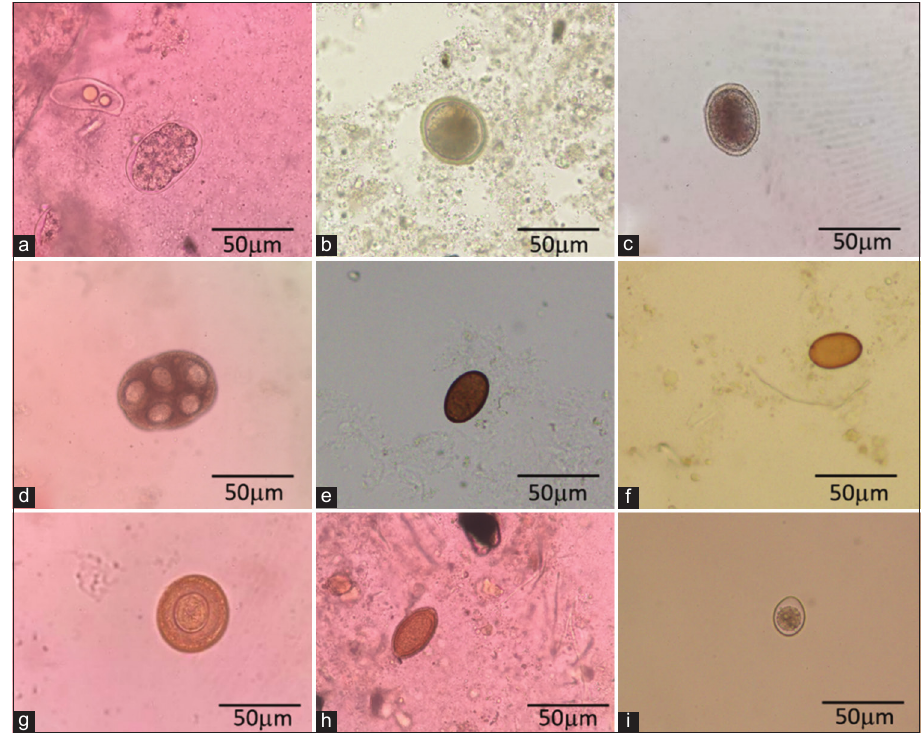
Figure-2: The fecal eggs of gastrointestinal parasites in owned and sheltered cats within Yangon region. (a) Ancylostoma spp. Egg, (b and c) Toxocara spp. eggs, (d) Dipylidium caninum egg, (e and f) Platynosomum spp. egg, (g) Taenia spp. egg, (h) Trichuris spp. egg, (i) Cystoisospora spp.